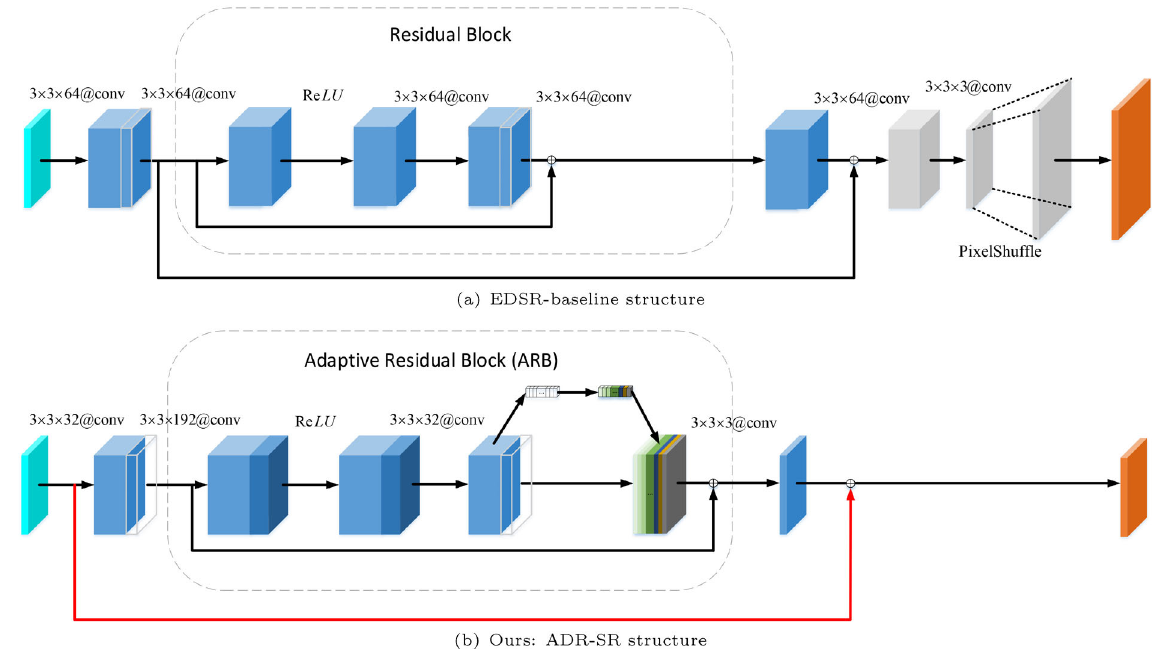
Fig. 1 Comparison of (a) EDSR-baseline structure with our (b) ADR-SR structure. Note that our ADR-SR does not have any upsampling layers and uses Adaptive Residual Block (ARB). The position of the global residuals is modified, and the depth and width of the network are also